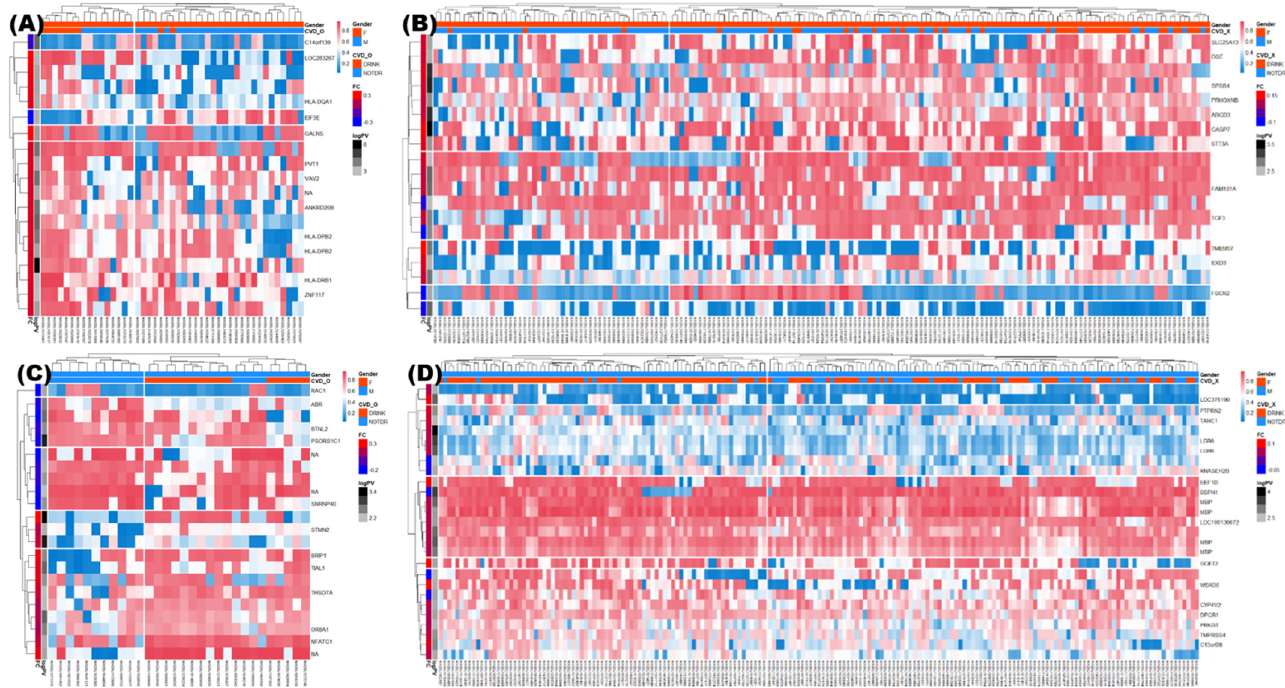
Figure 4. Heatmap of DMRs indicating the difference between four pairs of the four groups. Total 423 subjects were divided on the basis of presence of chronic cardiovascular diseases (CVDs); at least one of myocardial infarction, coronary artery, hyperlipidemia, and hypertension) or non-CVDs, and sexes (male or female). You may consider reporting this data in the body of results, rather than in the figure legends. This would help in avoiding the repetition between Figure 3 and Figure 4. ( A ) In females with CVD, t -test was performed on 9 drinkers versus 36 non-drinkers, and 19 DMRs were found to satisfy the criteria |fold change| > 0.2 and p -value < 0.01. ( B ) In males with CVD, t -test was performed on 15 drinkers versus 15 non-drinkers, and 22 DMRs were identified as satisfying the criteria |fold change| > 0.15 and p -value < 0.01. ( C ) In females with non-CVD, 42 drinkers versus 123 non-drinkers, and 19 DMRs were identified as satisfying the criteria |fold change| > 0.09 and p -value < 0.01. ( D ) In females with CVD, the pairs of 136 drinkers versus 47 non-drinkers were subjected to t -test, and 27 DMRs were identified as satisfying the criteria |fold change| > 0.06 and p -value < 0.01. In the heatmaps, higher methylated regions between drinkers and non-drinkers of the four groups are indicated as red annotation bars in drinkers. A higher significance deduced from a lower p -value is indicated as darker gray annotation bar. Sexes and CVD are indicated as column annotation bars.